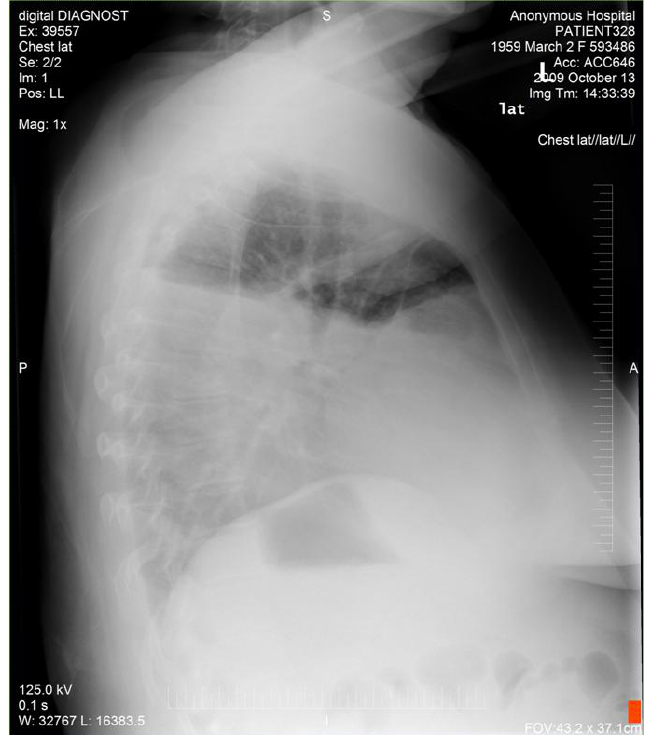
FIGURE 2. Lateral CXR showing right-sided pleural